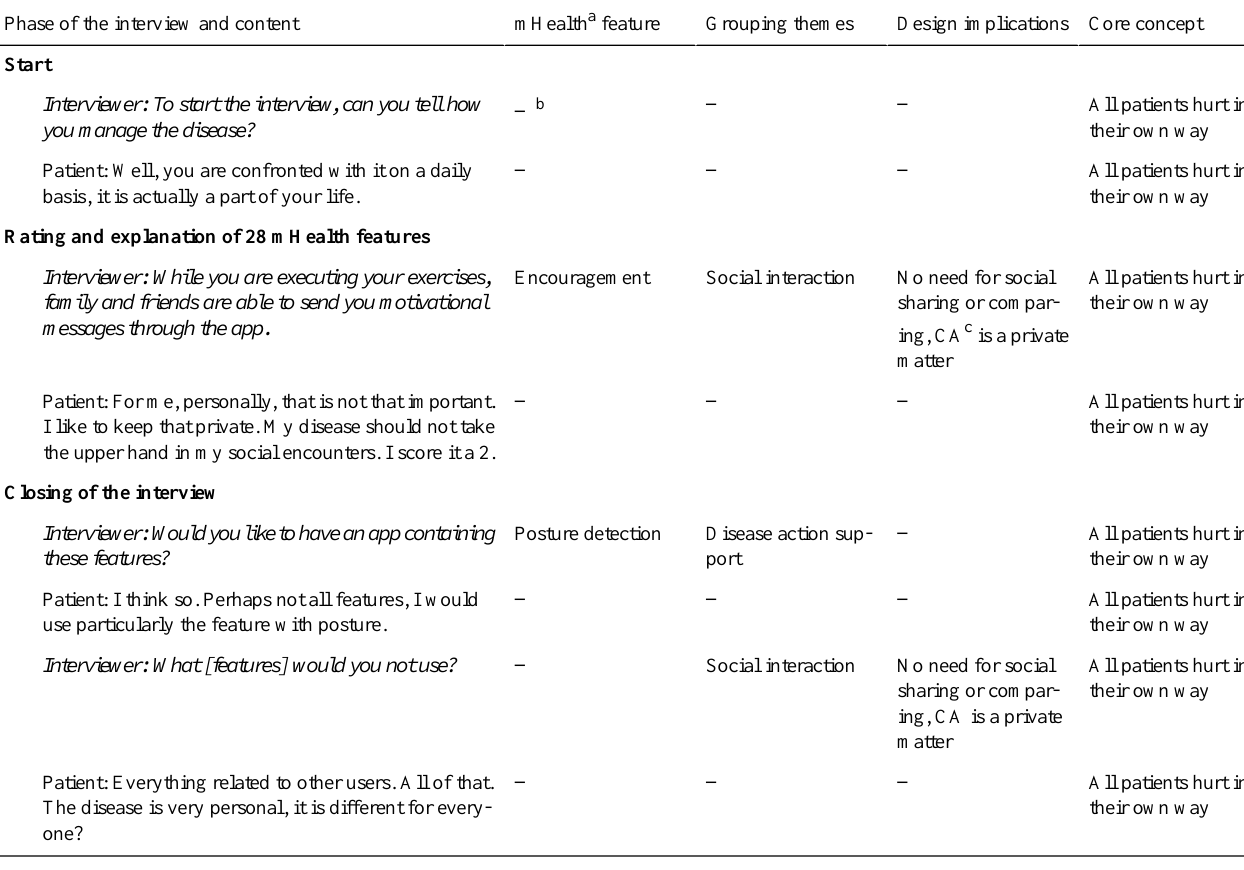
Table 2. Example of coding of the qualitative data into coding nodes, a category and